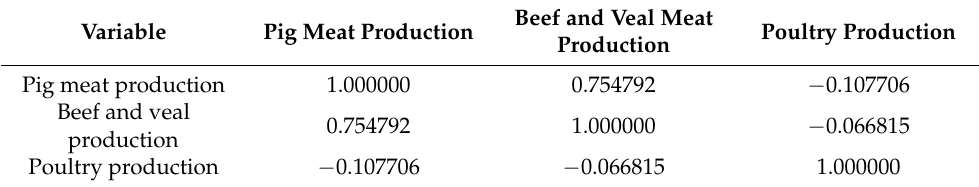
Table 2. Relationship between pork, beef and poultry production.